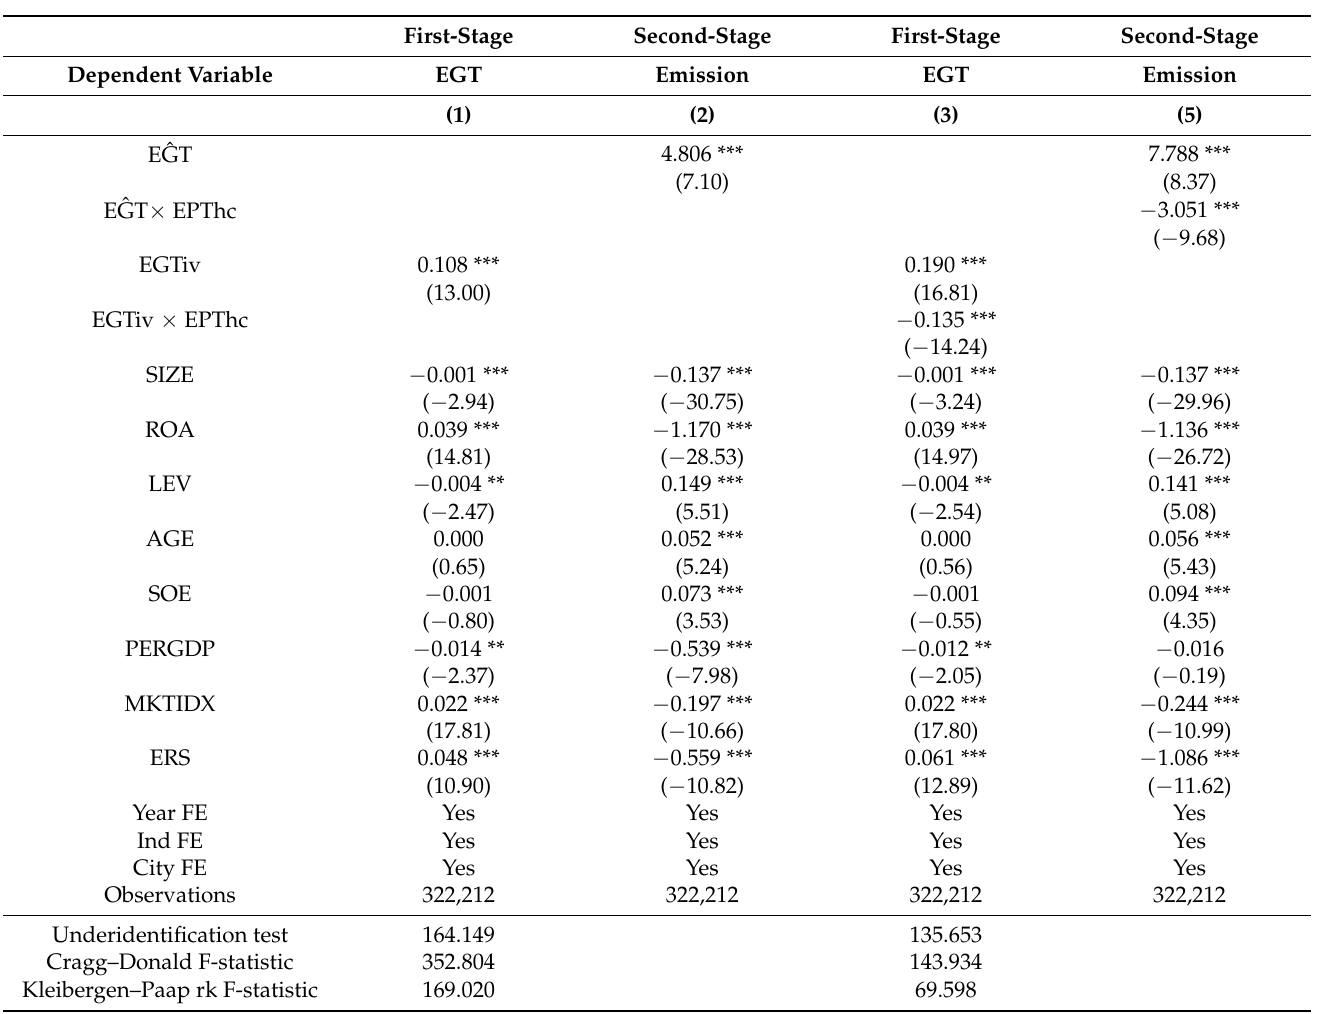
Table 4. IV estimations.